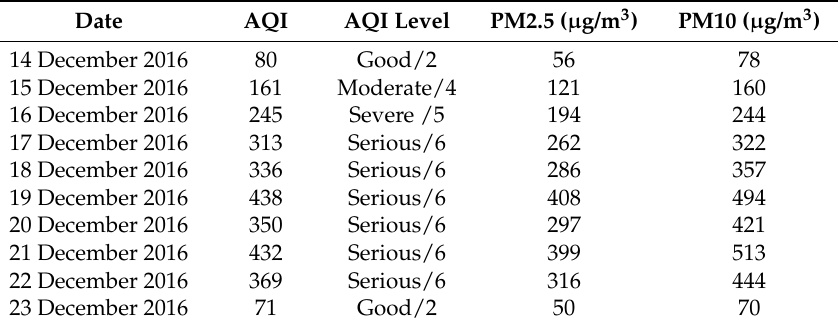
Table 7. Daily air quality of Baoding, China, 14–23 December 2016.